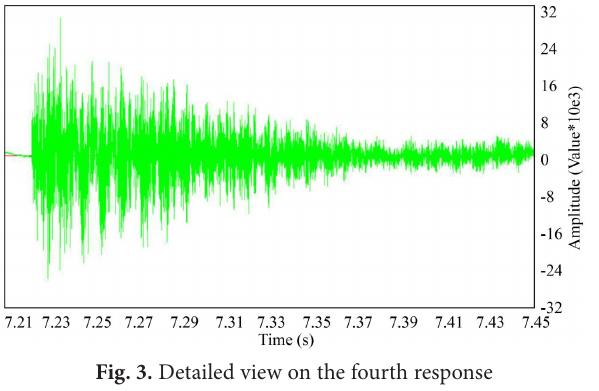
Fig. 2. Spectrogram of five knocks responses from Fig. 1 . Window size: 512 samples, windowing type: Blackmann-Harris